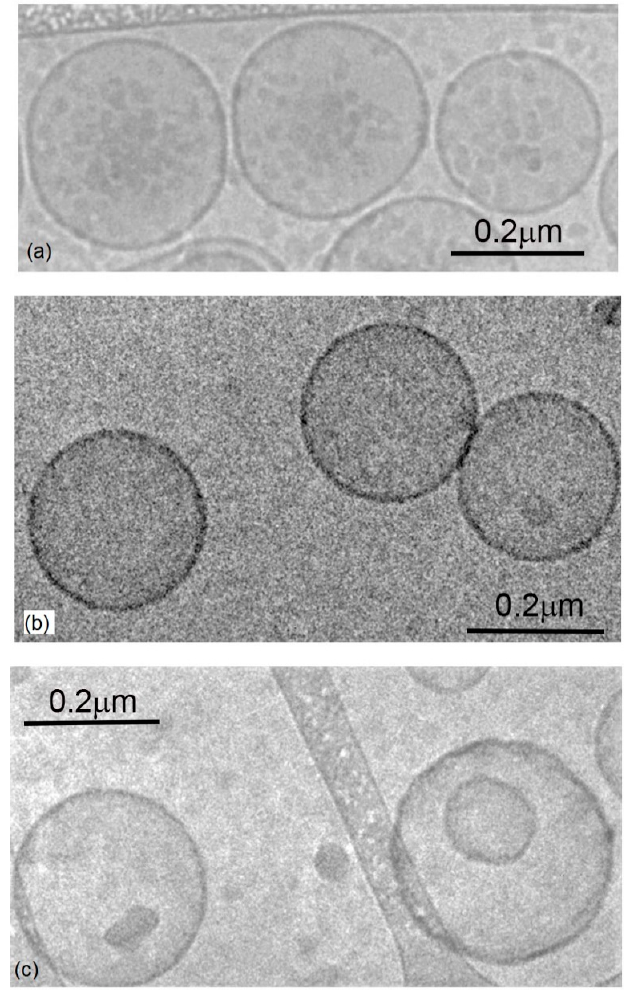
Figure 2. Structures of liposomes, hybrid vesicles, and polymersomes as determined using cryo-EM. Cryo-TEM images comparing ( a ) polymersome (PBd-PEO), ( b ) hybrid, and ( c ) liposomes (EcCL) in bu ff er indicates similar vesicle sizes. The vesicles appeared as unilamellar and spherical, with diameters typically in the range of 170–220